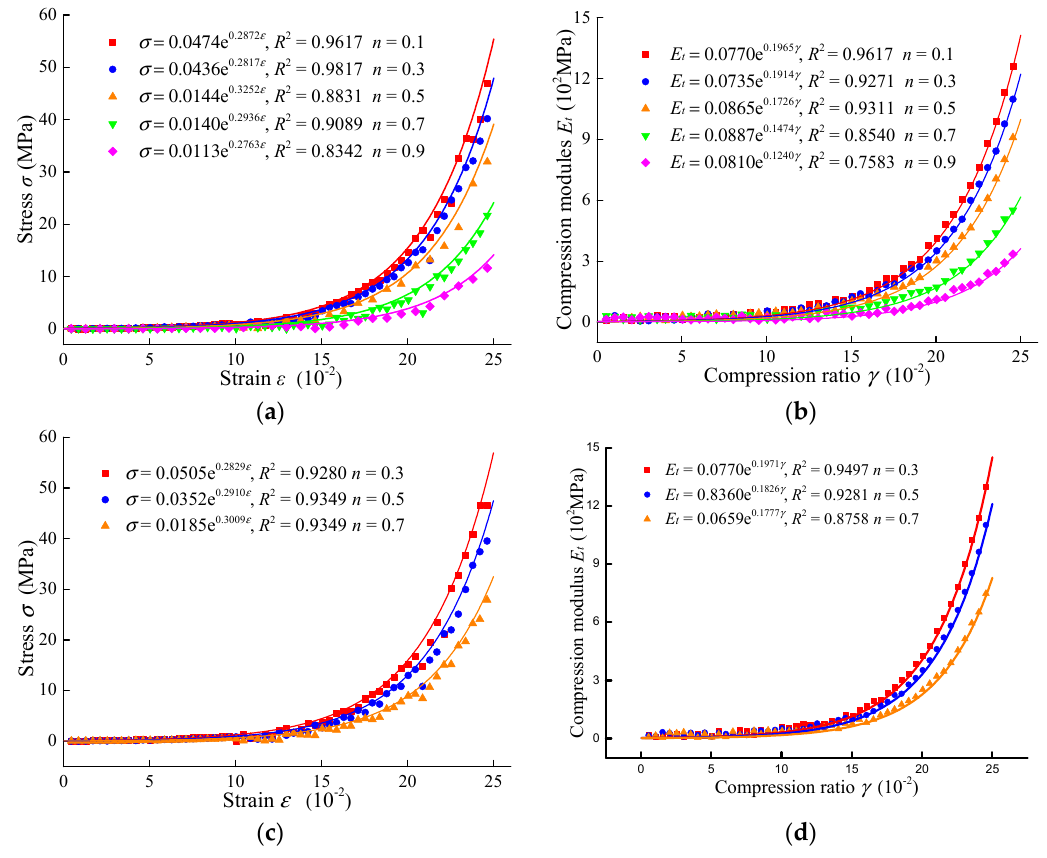
Figure 4. The compression properties of broken gangue: ( a ) relationship of stress-strain by continuous grading; ( b ) relationship of compression modulus-ratio by continuous grading; ( c ) relationship of stress-strain by discontinuous grading; and ( d ) the relationship of the compression modulus-ratio by discontinuous grading.